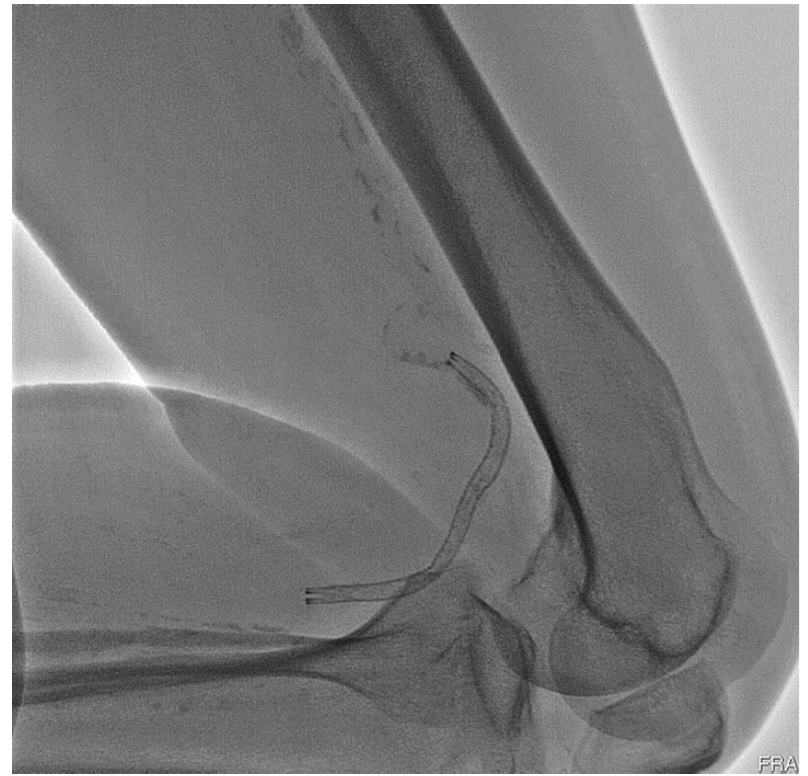
Figure 1. Deformed shape of a peripheral stent inside a bent patient knee.